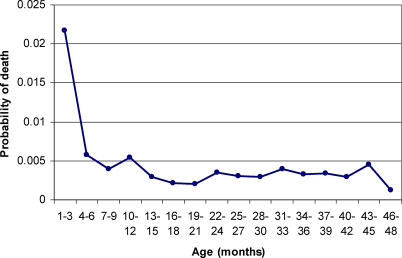
Probability of Child Death by Age (0–4 y of Age; 2,914 Births)